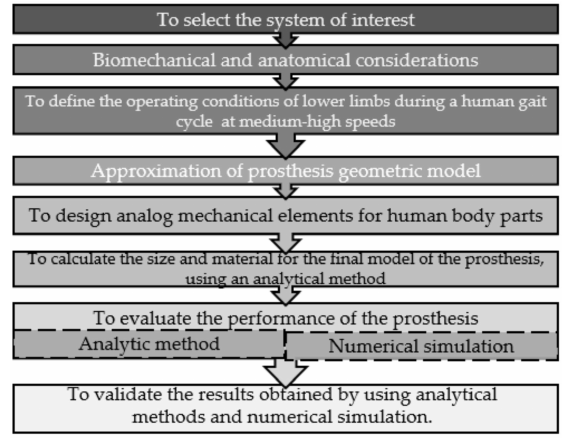
Figure 1. Flowchart of the methodology used for prosthesis development and